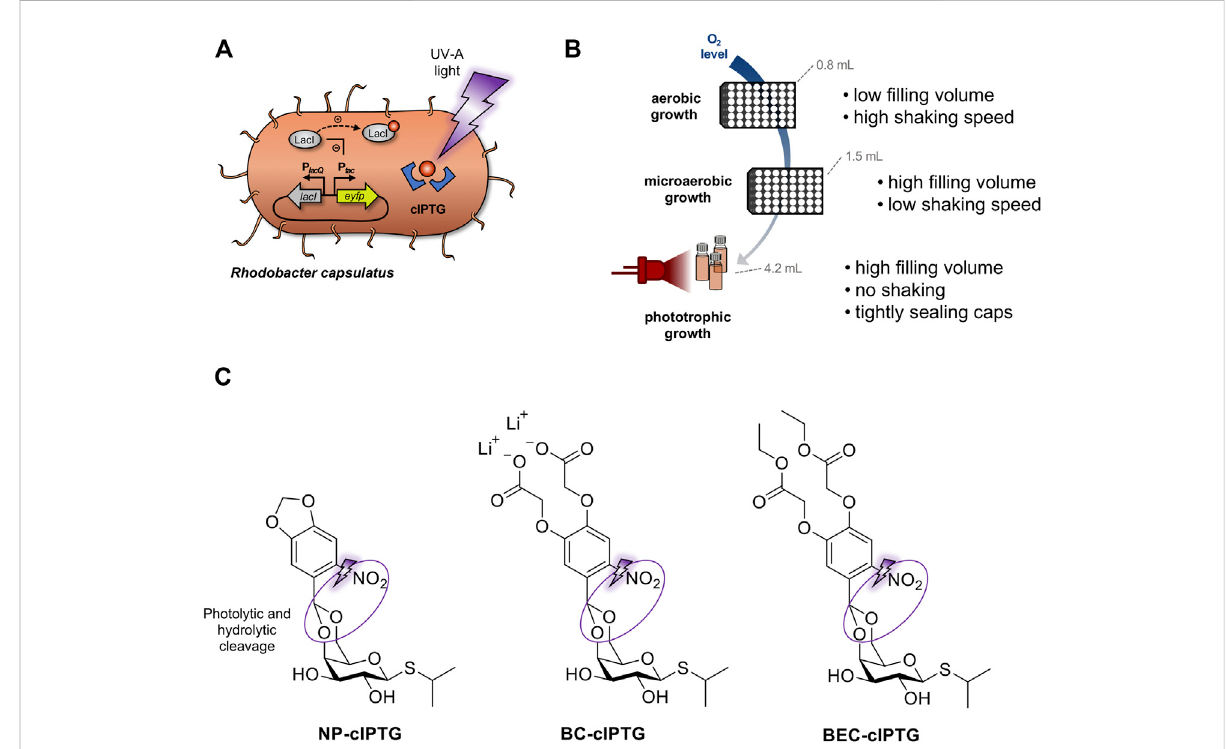
FIGURE 1 Establishmentofoptochemicalcontrolovergeneexpressionin R.capsulatus undernon-phototrophicandphototrophicgrowthconditions. (A) Light-controlledexpressionofthereportergene eyfp in R.capsulatus usingphotocagedIPTG(cIPTG;redcirclewithblueframes).Uponillumination with UV-A light (purple fl ash symbol), the protection group is cleaved off, the previously inactive IPTG molecule is released and induces LacI/P tac - mediated eyfp expression. (B) For analyzing light-dependent control of gene expression, R. capsulatus cells were either cultivated under non- phototrophic conditions (i.e., aerobic or microaerobic conditions in Round Well Plates with fi lling volumes of 0.8 and 1.5 mL, respectively) or anaerobic,phototrophicgrowth conditions usingNIRlightLEDas solelightsource (redLEDdiodes; λ max =850 nm,smallscale screwneckvials). (C) Photocaged IPTG variants NP-cIPTG, BC-cIPTG and BEC-cIPTG used in this study as well as the respective cleavage sites addressed by photolysis and subsequent enzymatic hydrolysis (purple